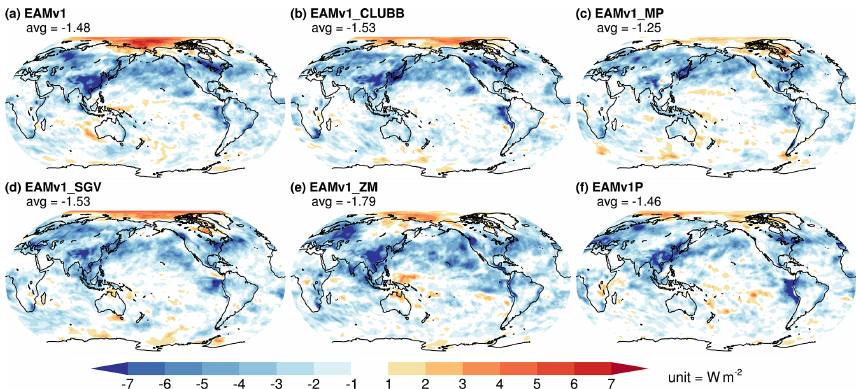
Figure 14. ERF aci estimated using the Ghan (2013) method in (a) EAMv1, (b) EAMv1_CLUBB, (c) EAMv1_MP, (d) EAMv1_SGC, (e) EAMv1_ZM, and (f) EAMv1P.